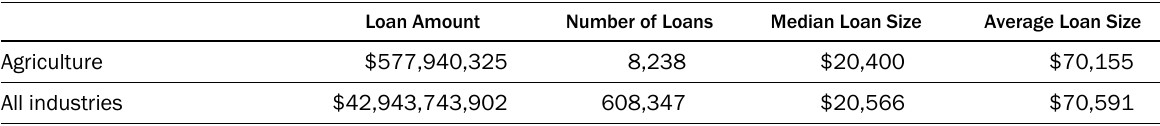
Table A2. Paycheck Protection Program (PPP) Loan Recipients with Fewer than Two Years of Business